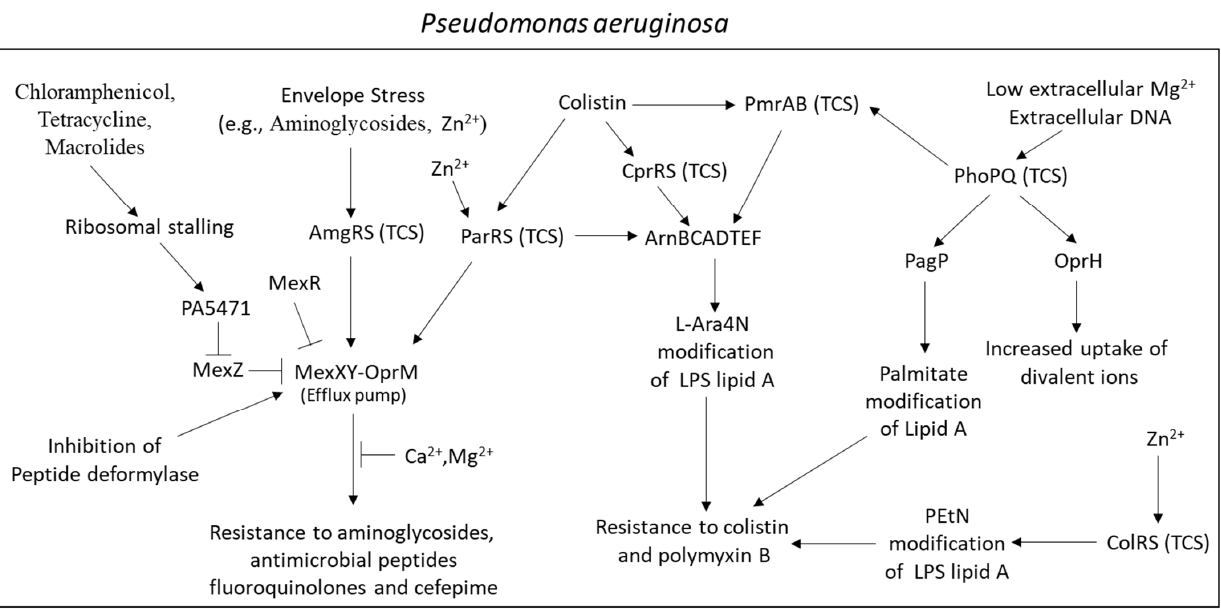
Figure 2. Induction of antibiotic resistance in Pseudomonas aeruginosa by antibiotics, zinc ions, and low concentrations of extracellular magnesium ions . The expression of the MexXY-OprM efflux pump responsible for multidrug resistance is regulated by several factors including ribosome- targeting antibiotics and the TCSs AmgRS and ParRS. AmgRS is activated by envelope stress, and ParRS is activated by the cationic antimicrobial peptide colistin as well as zinc ions. Moreover, colistin activates other TCSs including CprRS and PmrAB. The latter TCS is also affected by the TCS PhoPQ, which is activated by low extracellular magnesium ion concentrations, and extracellular DNA which sequesters magnesium ions. Extracellular DNA is a central component of Pseudomonas aeruginosa biofilms. The TCSs ParRS, CprRS, and PmrAB induce the translation of the arnBCADTEF operon which is responsible for the L-Ara4N modification of LPS, resulting in resistance to colistin. Additionally, LPS is modified by palmitoylation through PhoPQ-mediated upregulation of pagP , and by PEtN attachments regulated by the ColRS TCS.